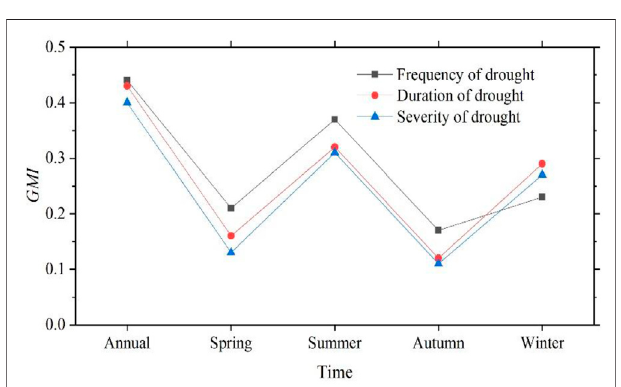
FIGURE 12 | GMI of seasonal drought characteristic variables in